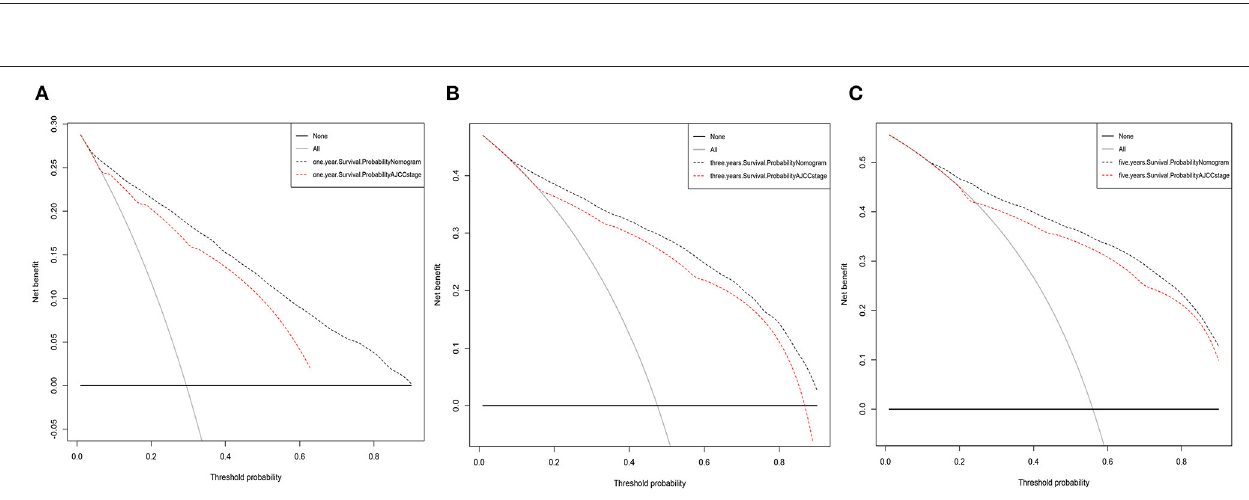
FIGURE 6 | Decision curve analysis for the Nomogram and AJCC stage in prediction of prognosis of elderly lung adenocarcinoma patients at 1-year (A) , 3-year (B) , and 5-year (C) CSS point in the validation